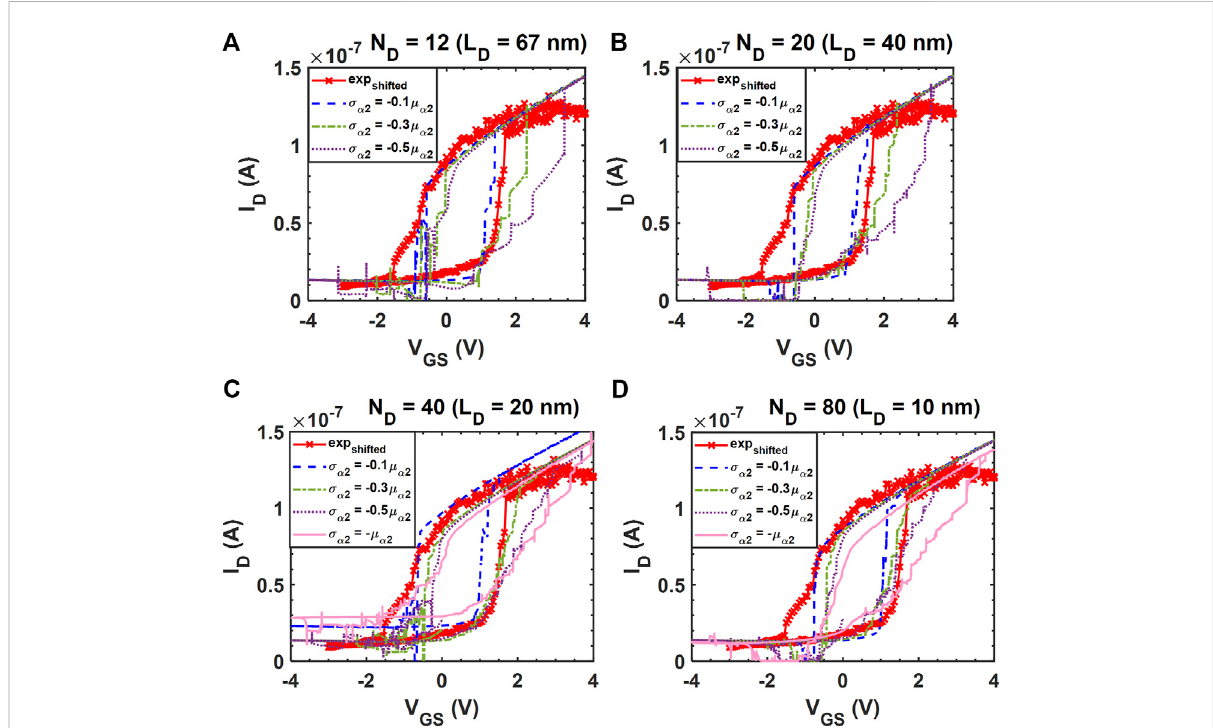
FIGURE 3 Experimental(solid line with crosses) and simulated “ I D vs. V GS ” transfercharacteristics of theFeFET inFigure 1 with an 8 nm-thick WO x channel (Halter et al., 2020), different number of HZO domains ( N D ), and varying standard deviations of the Landau coef fi cients ( σ α 2 ) at a source-to-drain